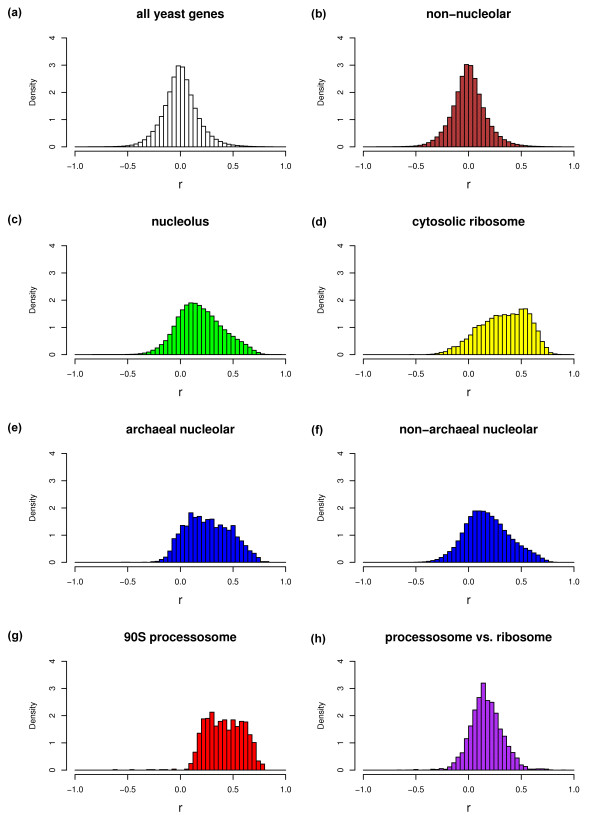
Survey of nucleolar/ribosomal gene expression. Histograms of sets of pairwise Pearson correlation coefficients computed from vectors of gene expression ratios for gene pairs. The distributions of Pearson correlation coefficients (each obtained from the pairwise comparison of expression profiles of two genes) gives an impression of the global similarity of expression patterns in a group of genes. Random data would give a Pearson correlation coefficient distribution centered around 0 (no correlation). The more a distribution deviates towards +1 compared to a 0-centered bell shape, the more similar a group of genes is expressed across the whole expression compendium. Gene pairs were formed within or between the functional/evolutionarily-defined groups of genes that are under investigation here. (a) Correlation within all yeast genes. (b) Correlation within genes that do not encode nucleolar proteins. (c) Correlation within genes for nucleolar proteins. (d) Correlation within genes for ribosomal or ribosome-associated proteins. (e) Correlation within nucleolar genes that stem from archaea. (f) Correlation within nucleolar genes that do not stem from archaea. (g) Correlation within genes that encode 90S processosome components. (h) Correlation between genes for ribosome proteins and 90S processosome proteins. Note that the distributions for the ribosomal protein genes and the 90S processosome strongly deviate from the rather 0-centered distribution of 'all genes-versus-all gene' comparisons. However, the distribution for gene pairs in which one partner is a 90S processosome component and the other partner is a ribosomal component deviate much less from the random shape and, thus, indicate distinct expression programs.